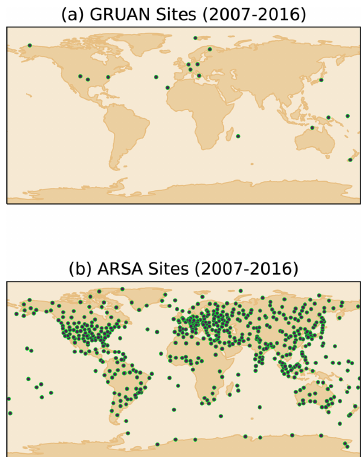
Figure 5. Locations of sites within the two radiosonde archives: (a) the GCOS Reference Upper-Air Network (GRUAN) and (b) the Analyzed RadioSoundings Archive (ARSA). Locations are specific to upper-air soundings made between 1 June 2016 and 31 Decem- ber 2016. Further details regarding the individual GRUAN sites are given in Table